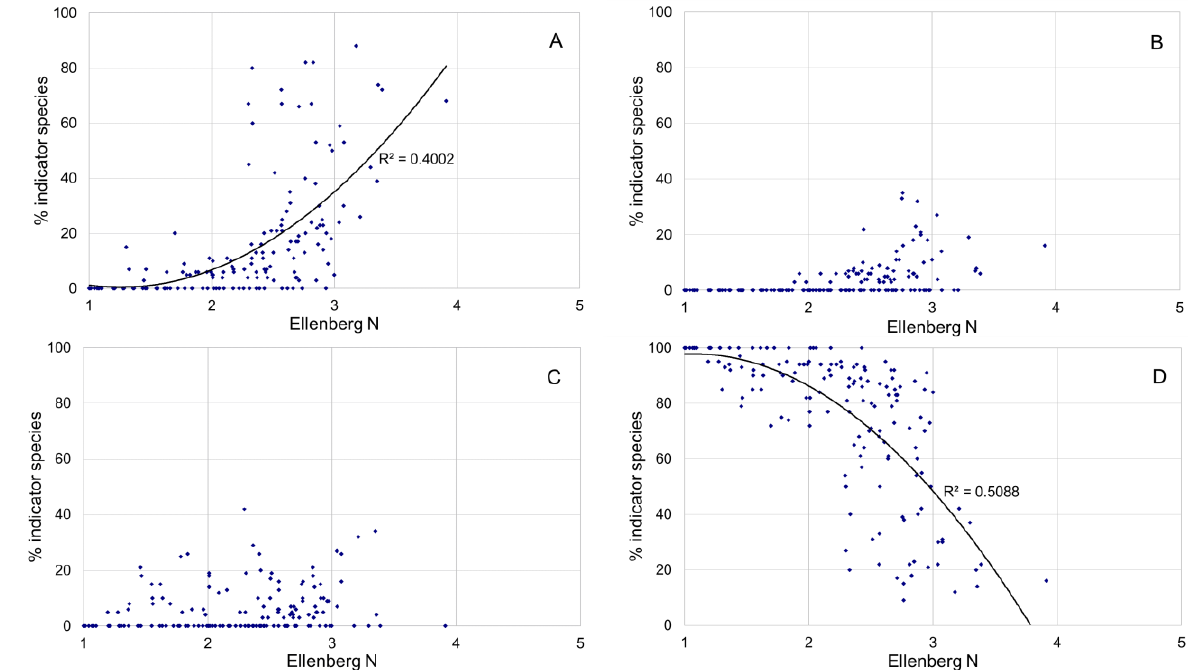
Figure 4. Percentages of plant species indicating mire margin to expanse gradient (y-axis) in relation to Ellenberg nitrogen value (x-axis). Subtypes of mire margin influence are (A) Sumpfigkeit , (B) Quelligkeit and (C) Bruchmoorigkeit . (D) refers to mire expanse vegetation including indifferent species. Percentages of plant species indicators for mire margin–expanse gradient are derived from the presence-absence data for vascular plants and mosses. Ellenberg nitrogen values are derived from cover values for vascular plants. Regression lines are shown only for correlations with statistical significance ( R 2 > 0.4).